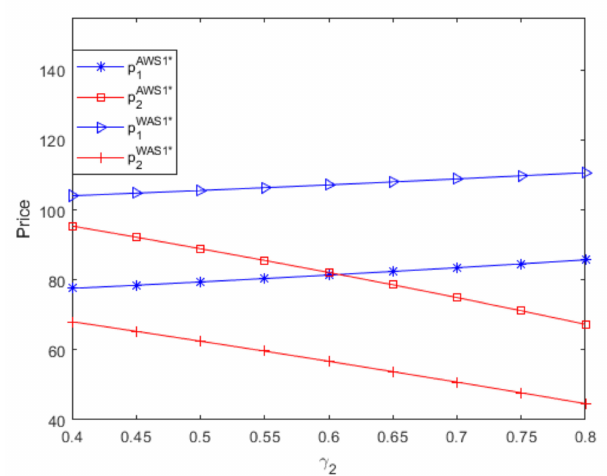
Figure 4. Changes of optimal retail prices with γ 2 in AWS1 and WAS1 models.